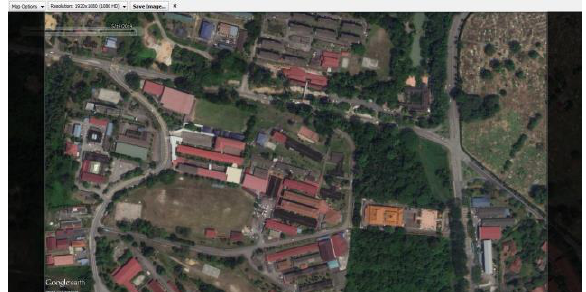
Figure 9b. Intermediate resolution - HD (1920 x 1080)